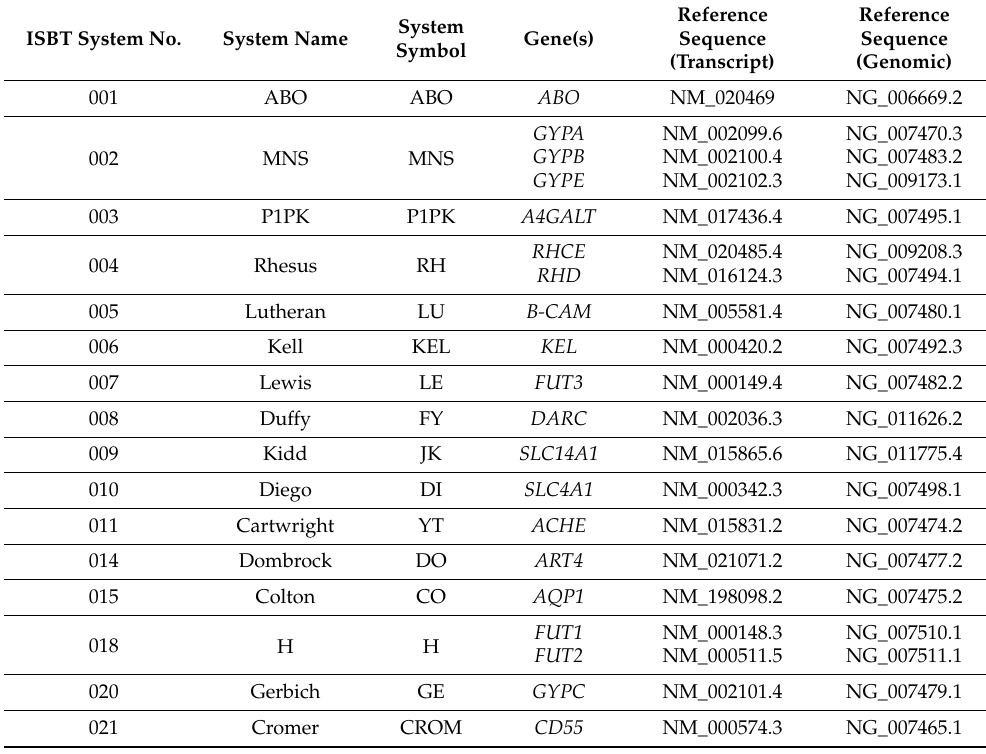
Table 1. Blood group systems and HPA included in the NGS test system. ISBT System No.